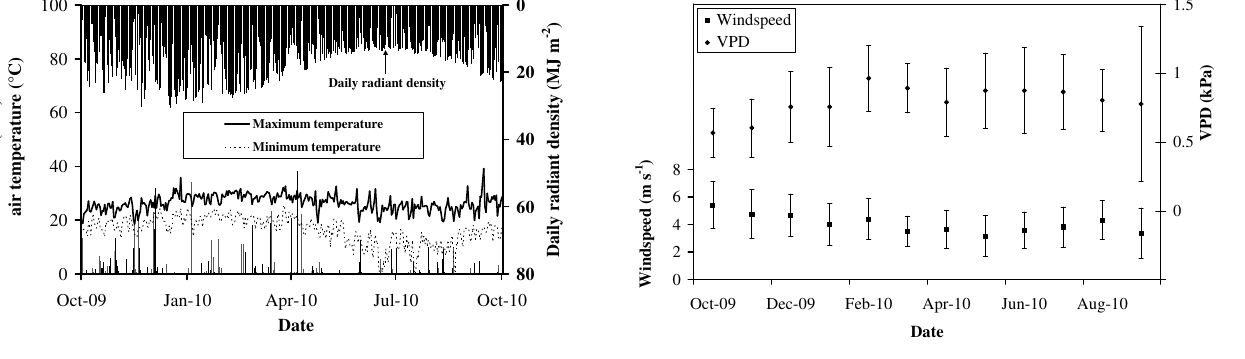
Fig. 3. Monthly average wind speed and VPD (with standard devia- tion error bars) at the Mfabeni Mire from October 2009 to Septem- ber